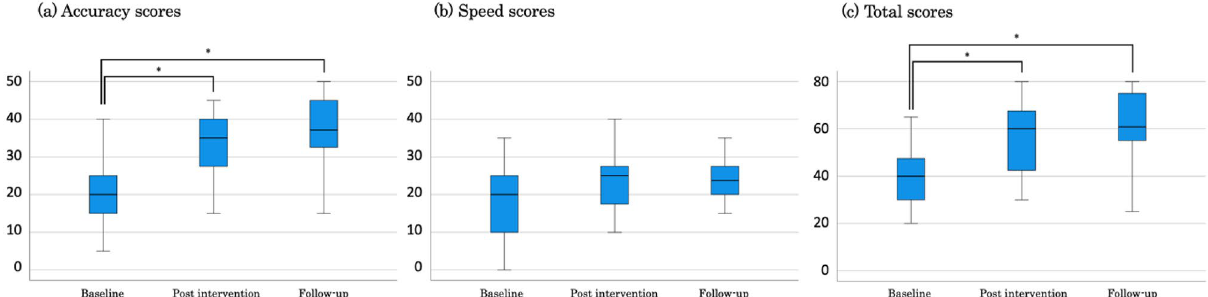
Figure 2. Palpation scores at each time point for the ultrasound group. *: p < 0.05.